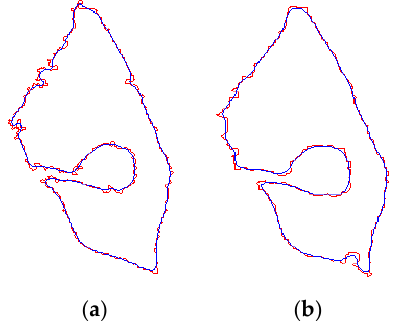
Figure 2. Curve smoothing for two different shapes. ( a ) Shape A, ( b ) Shape B. The red line is the original contour, and the blue line is the Gaussian smoothing result.